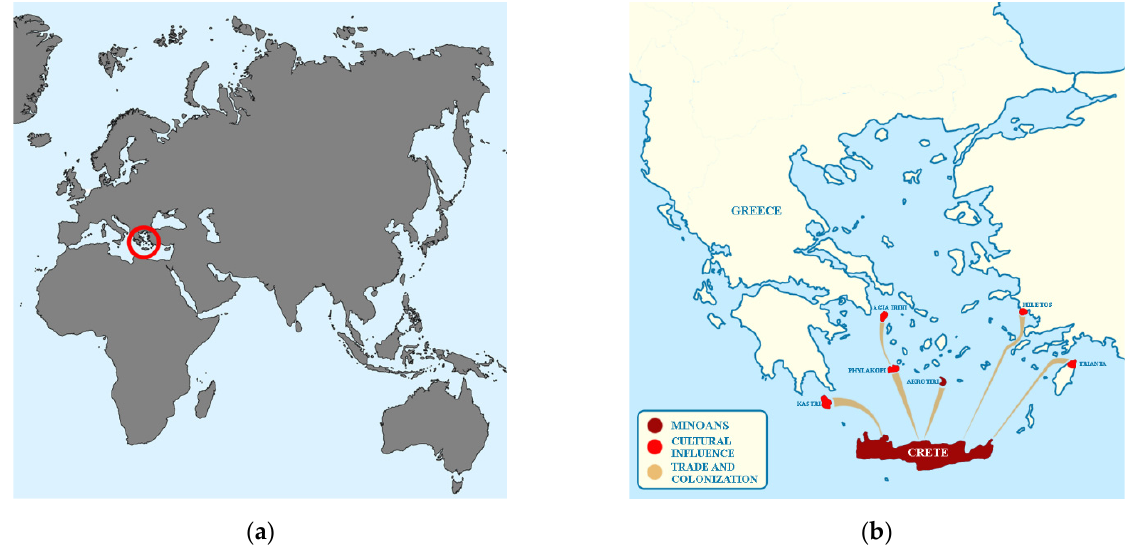
Figure 13. Minoan civilization. ( a ) Location; ( b ) Areas of cultural influence (possible colonies), trade and colonization route.